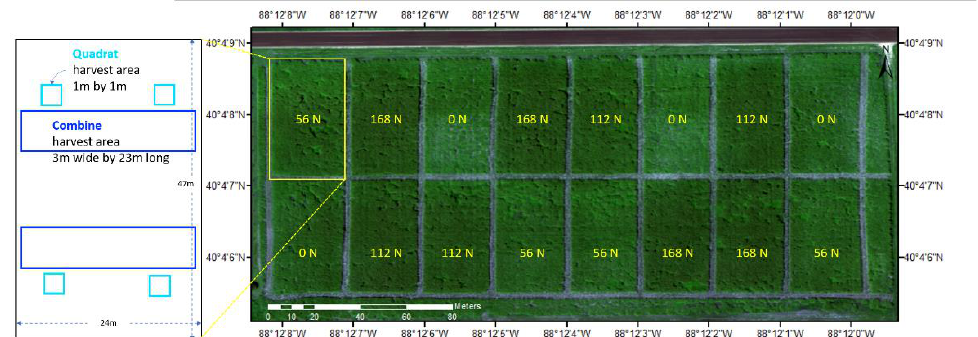
Figure 1. Geographic location of the study area and experimental design for subplots. The RGB imagery is from 6 July 2018, and the spacing between subplots is 3 m. Coordinates are referred to GCS_WGS_1984.